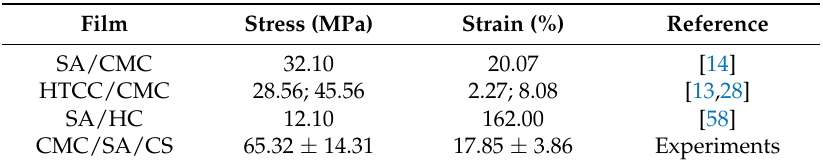
Table 7. Mechanical performance data